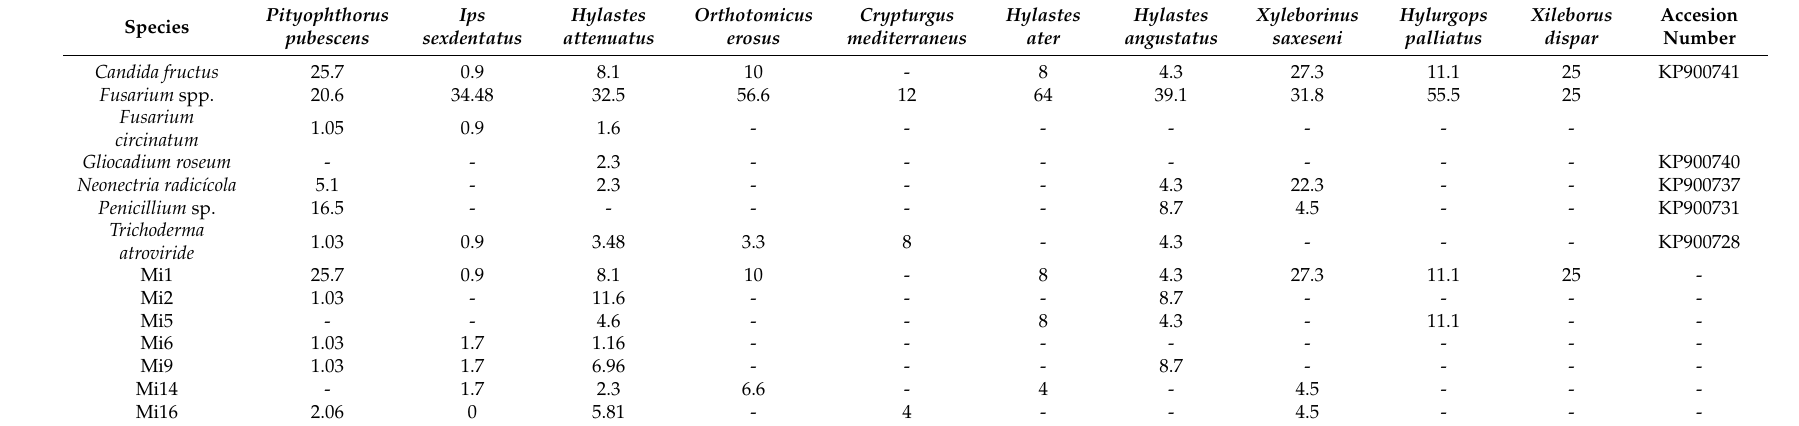
Table 3. Percentage of bark beetles harbouring each fungal